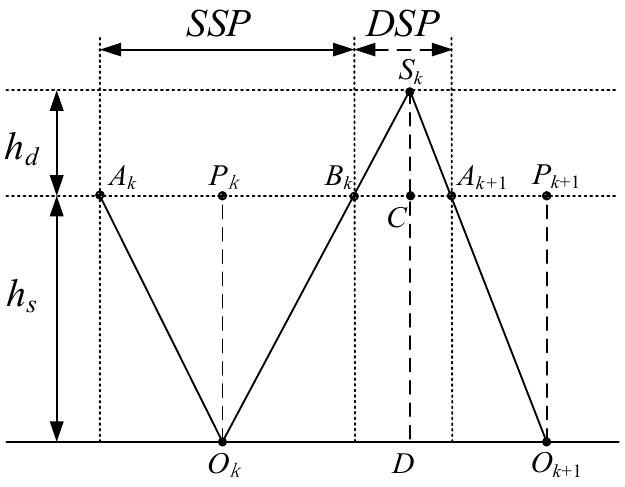
Figure 9. A schematic representation of LIPM and LPM.